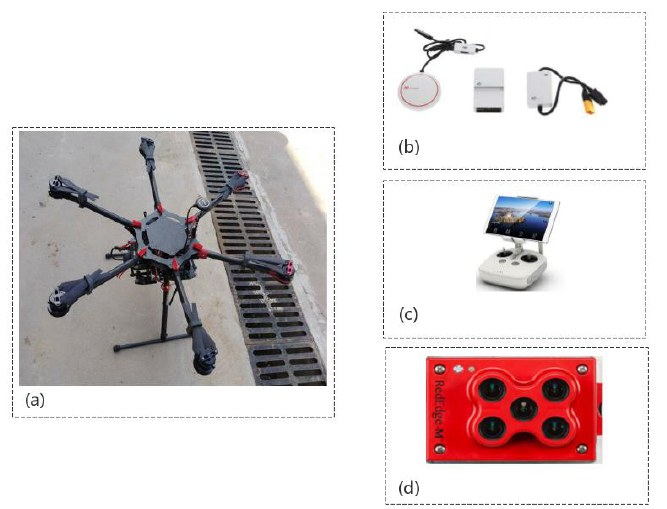
Figure 3. Unmanned aerial vehicle (UAV) camera system: DJI S800 UAV ( a ), Dji A3 flight controller ( b ), remote control ( c ) and RedEdge camera ( d ). Table 2. Spectral information of the RedEdge camera.